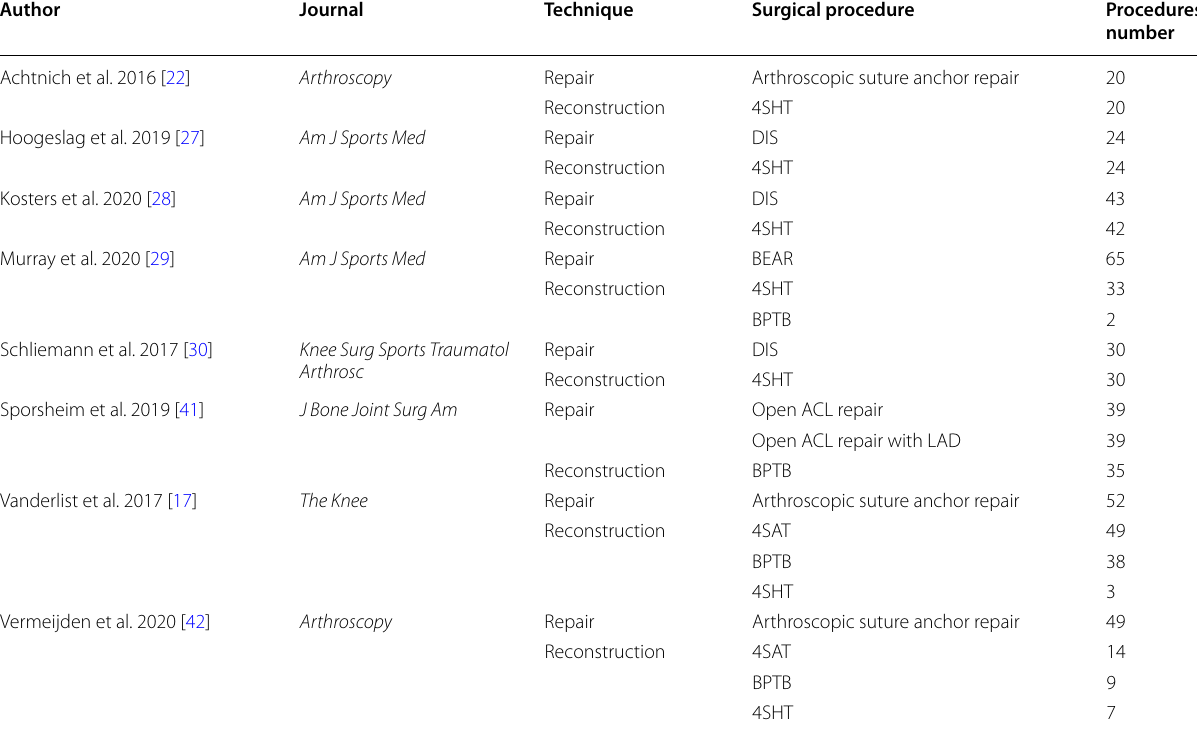
4SHT: four-strand hamstring tendon; DIS: dynamic intraligamentary stabilization; BEAR: bridge-enhanced ACL repair; BPTB: bone–patellar tendon–bone; LAD: ligament augmentation device; 4SAT: four-strand allograft